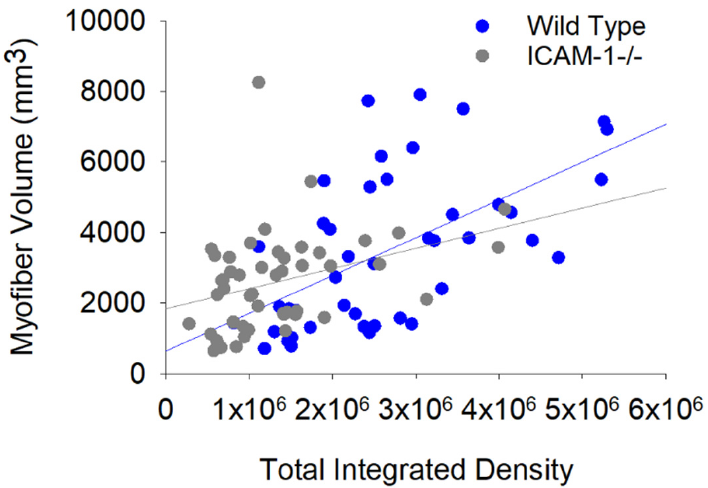
Figure 7. The relationship between integrated density and myofiber volume in Wild Type and ICAM-1-/- mice during injury-induced muscle regeneration. The scatter plot and regression lines display the total integrated density and corresponding myofiber volume (mm 3 ) within a segment for 7–28 days post-injury. Data and regression line for Wild Type mice (r = 0.59; Myofiber volume = 0.0011 × +634.80; n = 44 myofibers) and ICAM-1-/- mice (r =